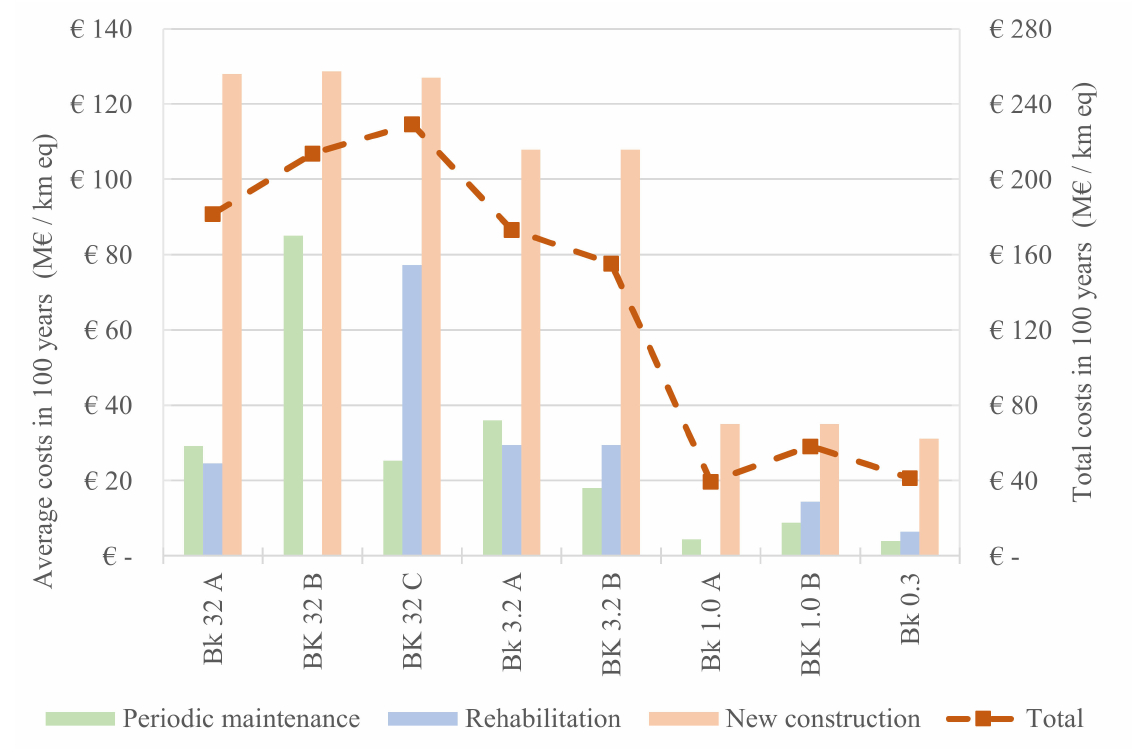
Figure 8. Average costs of maintenance, rehabilitation, and construction of road